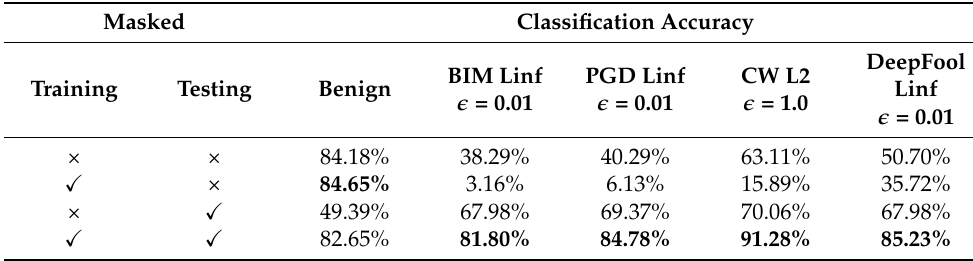
Table 2. Defense effect of using masked and nonmasked images during training and testing. Masked Classification